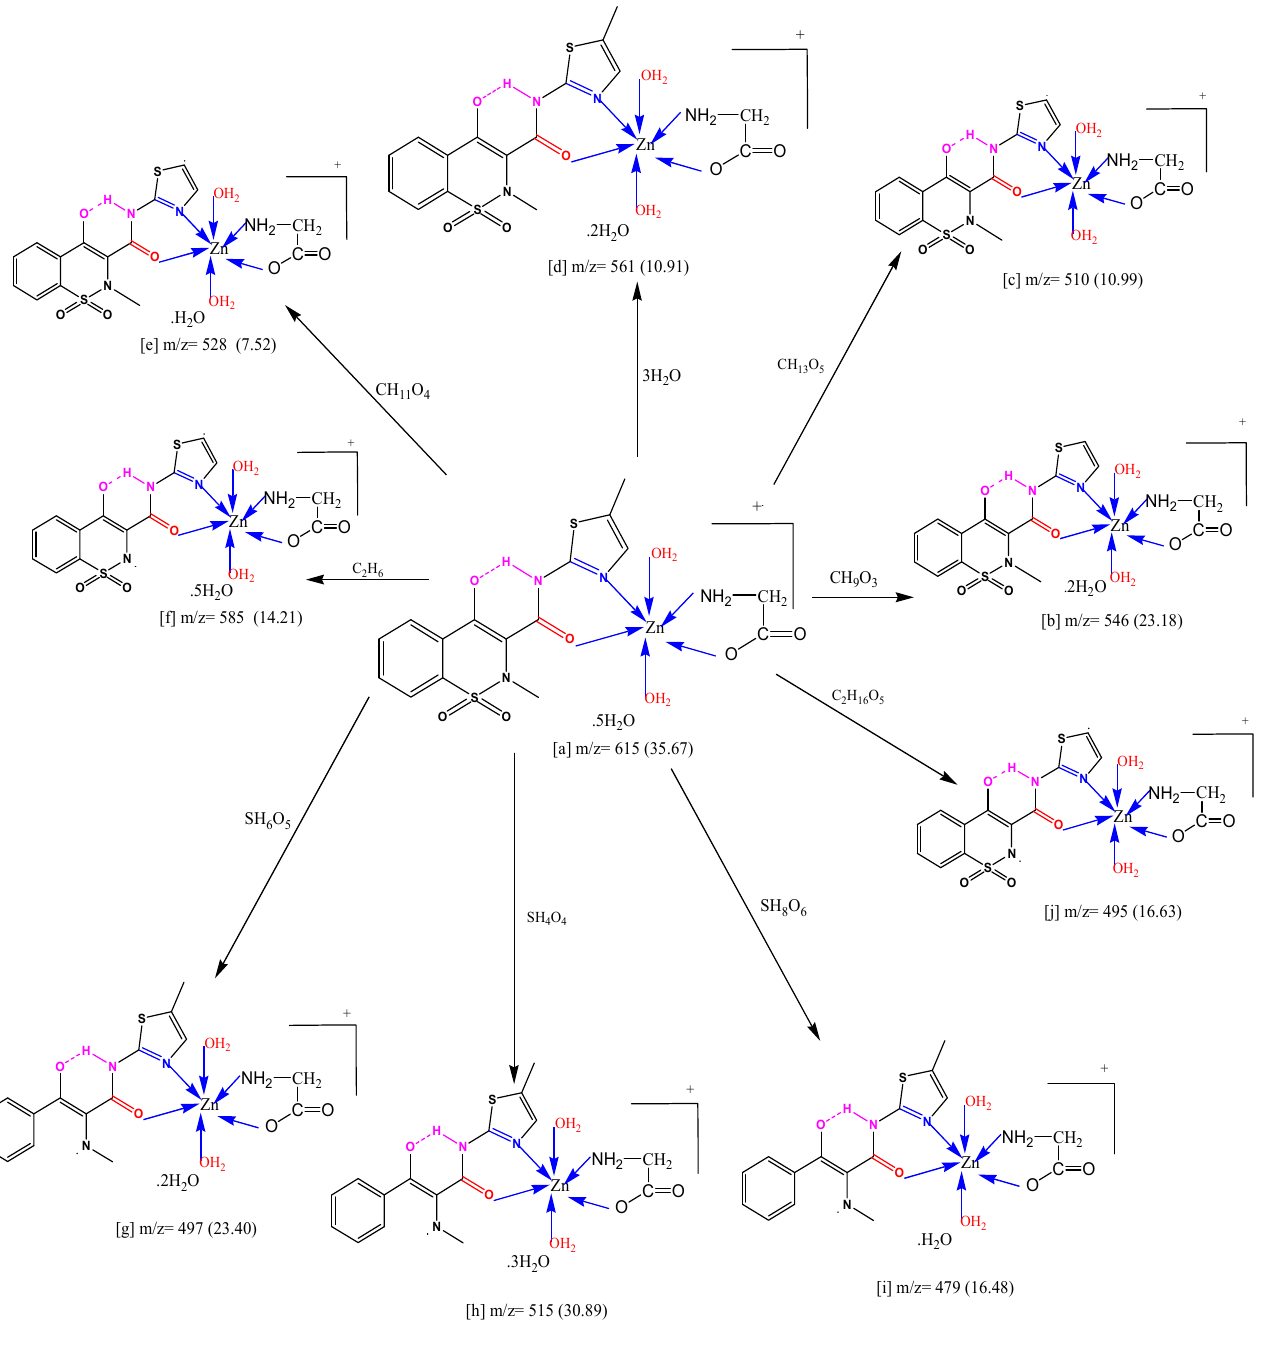
Scheme 3. Fragmentation pattern of ( E ) complex.